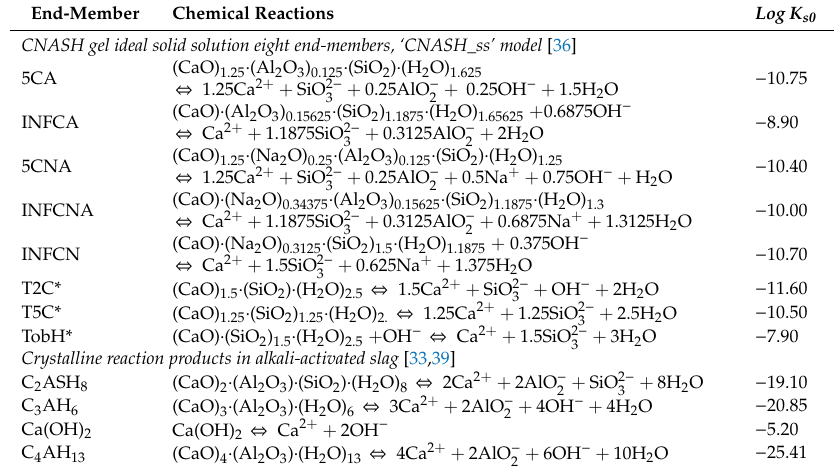
Table 3. Chemical reactions and equilibrium solubility products at 25 ◦ C and 1 bar for eight CNASH_ss end-members and secondary reaction products in alkali-activated